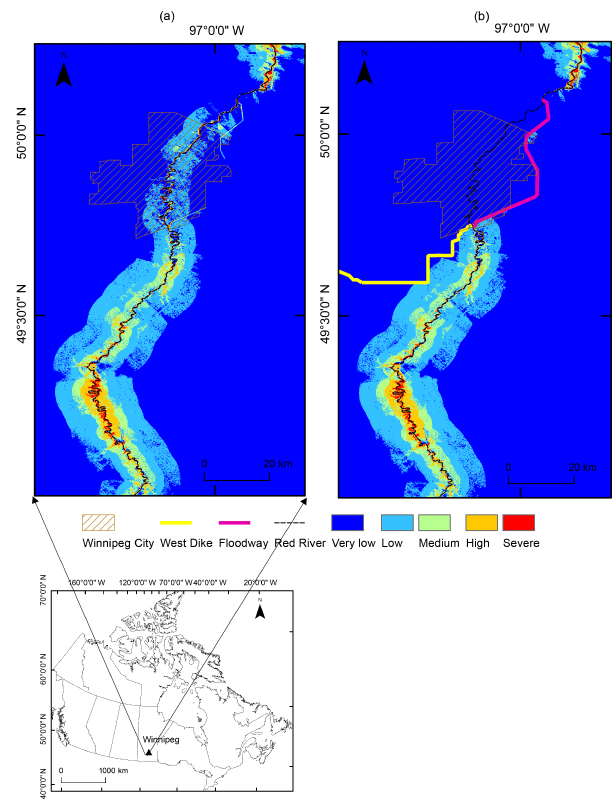
Figure 6. Hazard map for the Red River in Manitoba: (a) without considering flood protection structures in delineating hazard zones and (b) considering flood